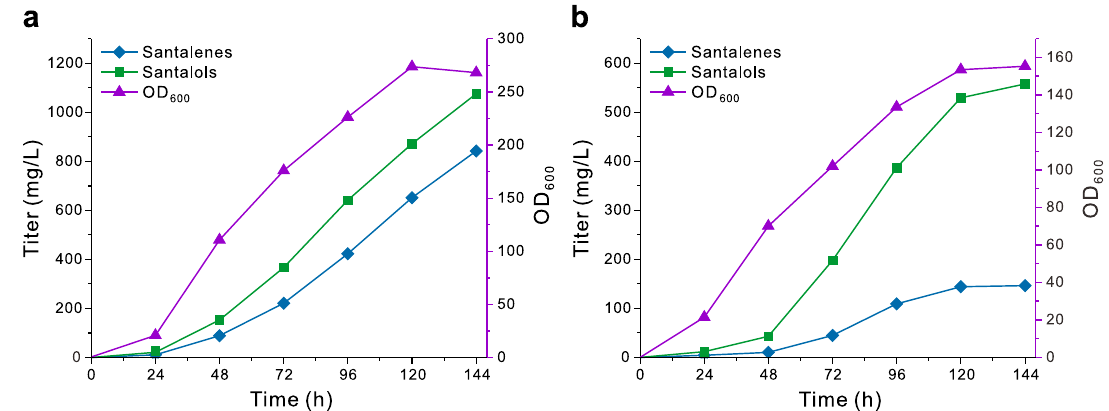
Fig. 7 Fed-batch fermentation of SZ22 (with three copies of SanSyn F441V and two copies of CYP736A167 ) and SZ24 (with three copies of SanSyn F441V and CYP736A167 ). The santalenes and santalols titers and OD 600 of SZ22 ( a ) and SZ24 ( b ). All data represent the mean of n = 2 biologically independent samples. Source data are provided as a Source Data fi